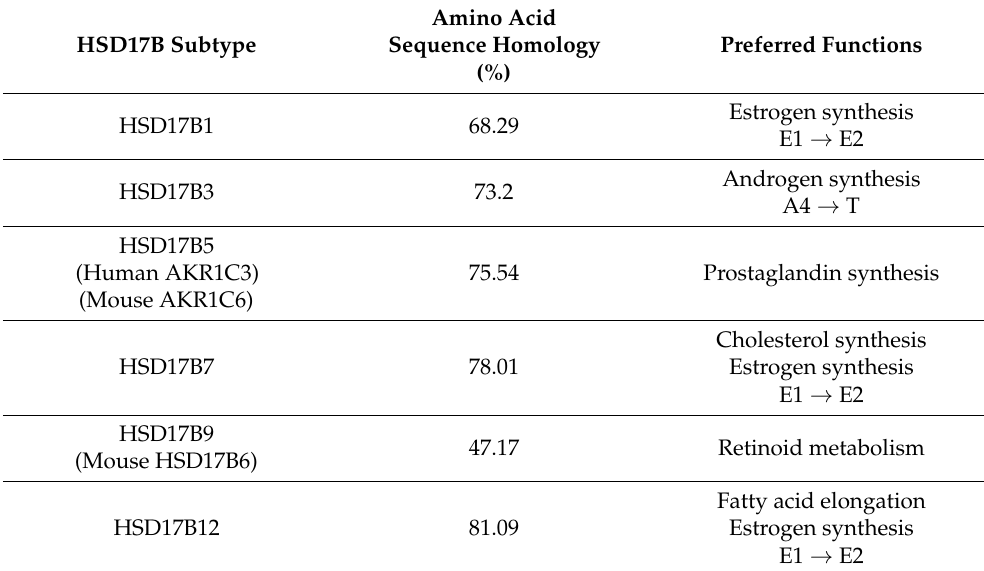
Table 1. Amino acid sequence homology of HSD17B enzymes between human and mouse.